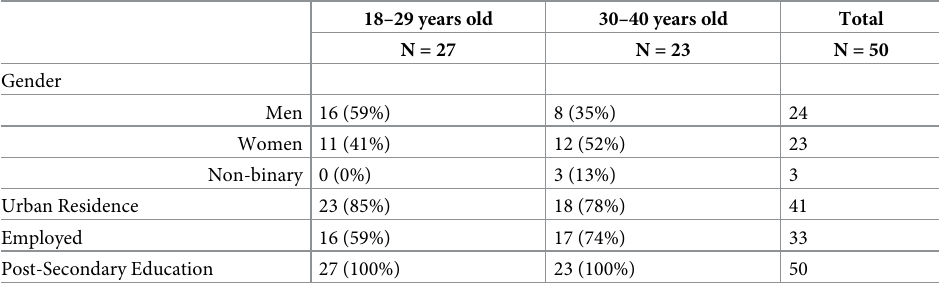
Table 2. Participant demographics.